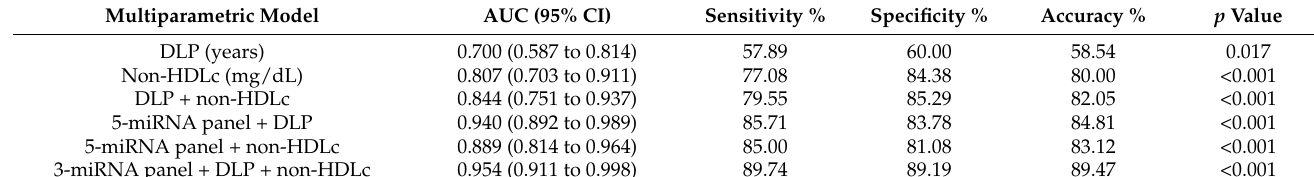
Table 4. Evaluation of the potential of clinical parameters (DLP and non-HDLc) and the multivariate models as SI biomarkers. AUC, area under the curve; CI, confidence interval. DLP: years of dislipidemia; miRNA: microRNA; non-HDLc: non-high-density lipoprotein cholesterol. Multiparametric Model